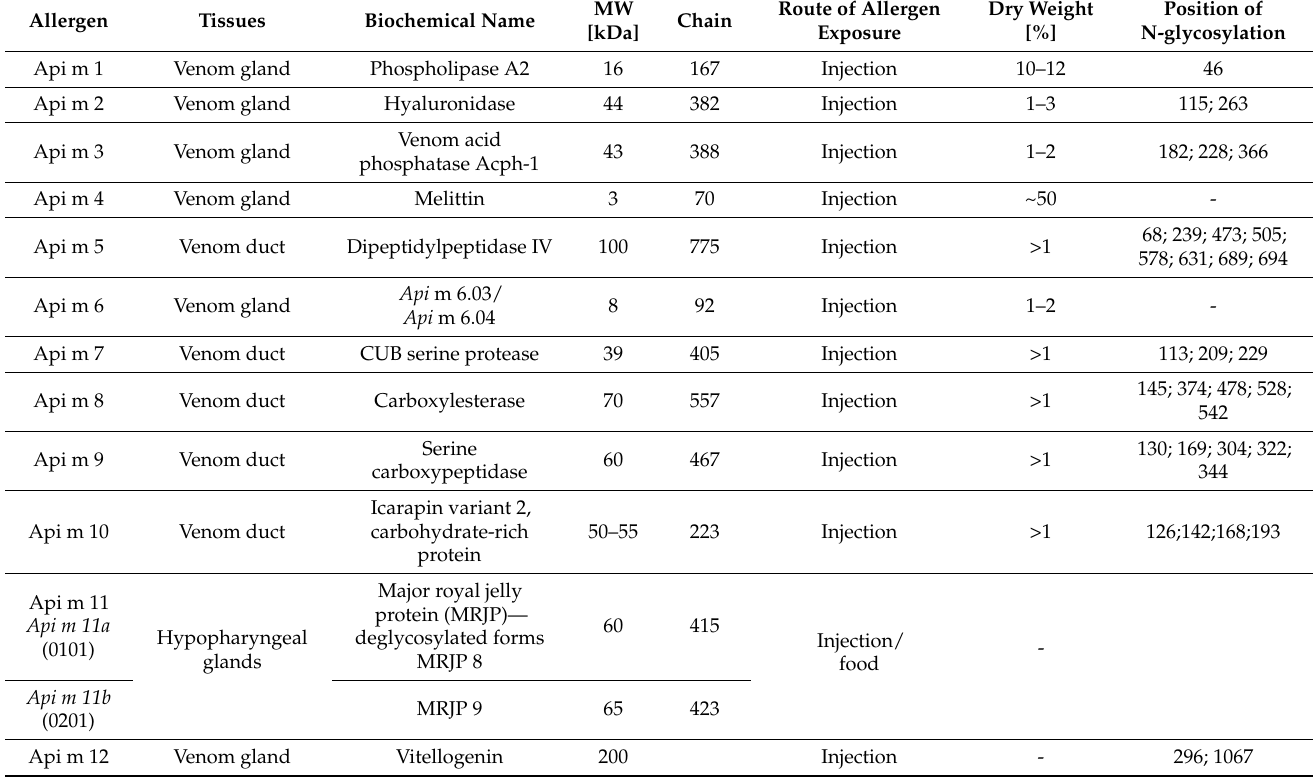
Table 3. Characteristics of allergenic fractions of honeybee ( Apis Mellifera ) according to WHO/IUIS Allergen Nomencla- ture Sub-Committee [45], characterisation and position of N-glycosylation according to the UniProt/Swiss-Prot protein knowledgebase